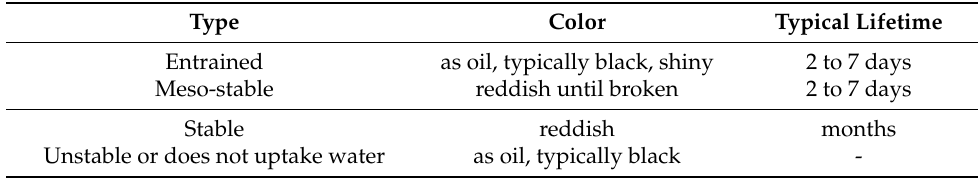
Table 6. Four ways by which oil uptakes water.